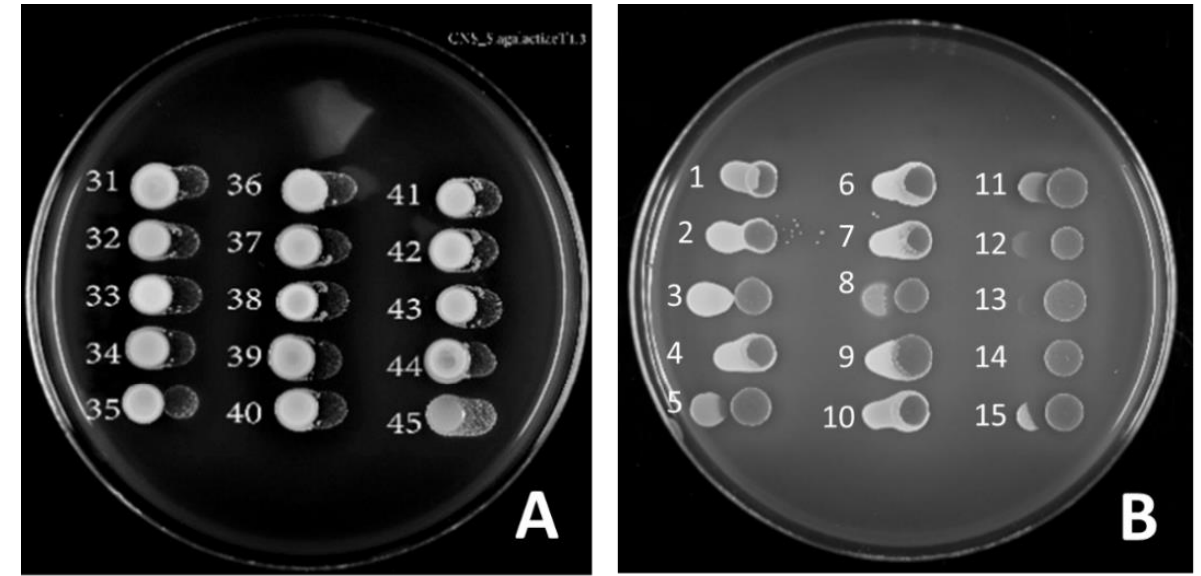
Figure 3. Example of the result of the agar spot competition assays: ( A ) the spots are colonies formed by S. chromogenes, the right spots are the colonies formed by S. agalactiae (No. 31 – 45) when the S. chromogenes were cultured at 24 h prior (PRIOR), and many colonies formed by S. agalactiae are degraded and lysed; ( B ) the spots are colonies formed by S. hominis , the right spots are the colonies formed by S. agalactiae when the S. hominis (No. 1 – 10) and S. warneri (No. 11 – 15) are cultured at 24 h later (AFTER), and many colonies formed by S. hominis (No. 1 – 4, 6, 7 ,9 and 10) are detached and are not degraded by S. agalactiae .